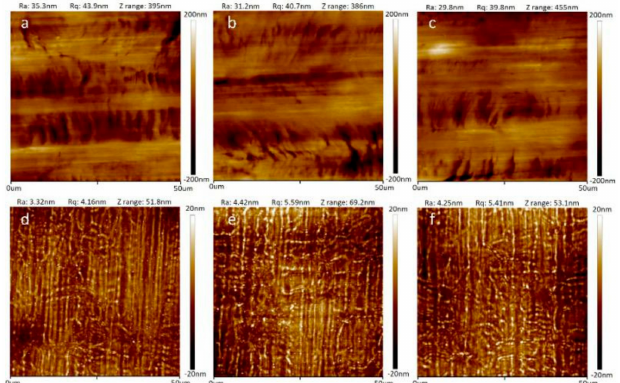
Figure 3. AFM micrographs of the substrate surfaces. ( a )–( c ) Results taken from a cleaned bare SUS 304 s.s. surface. ( d )–( f ) Results taken from the s.s. substrate covered with a 3 µ m-thick SU-8 resist